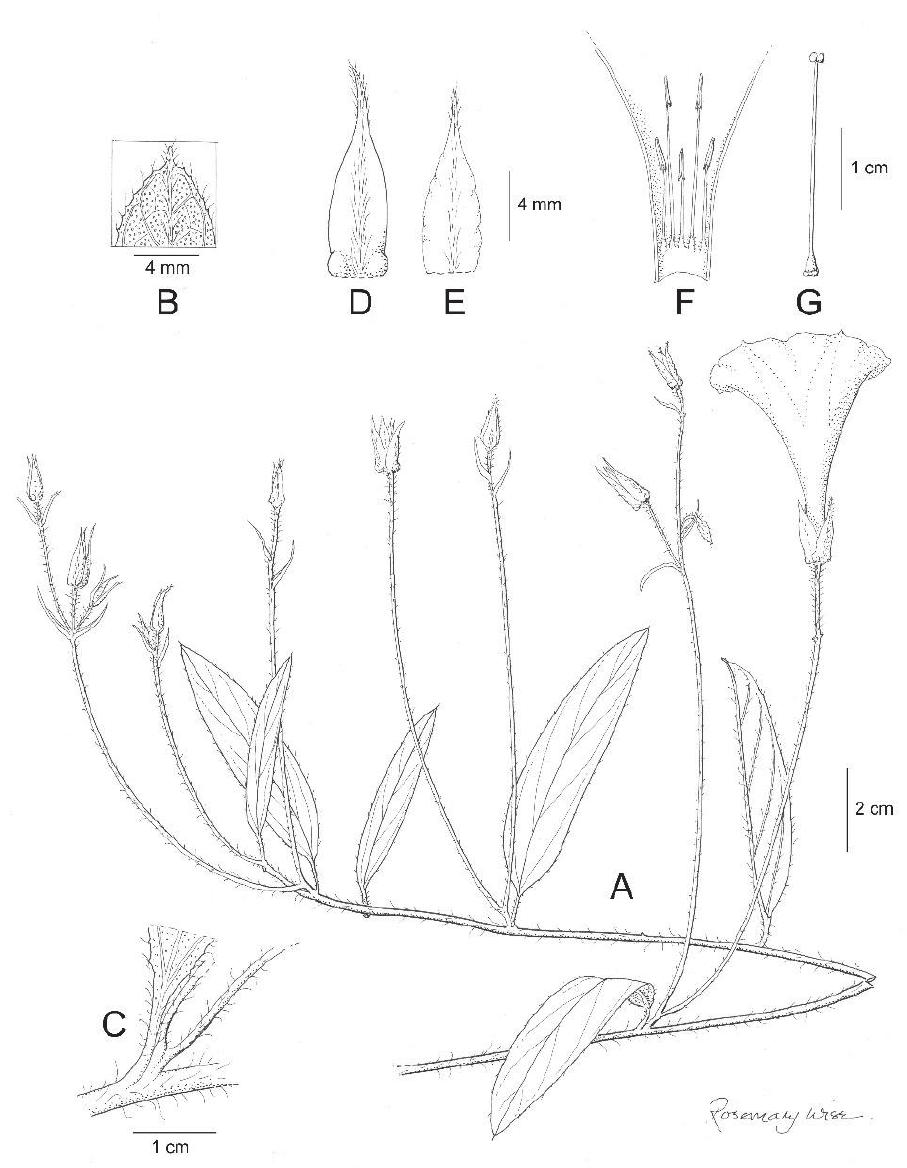
Figure 7. Ipomoea dolichopoda . A habit B leaf apex C leaf base, showing peduncle and inflorescence D Outer sepal e inner sepal F corolla opened out to show stamens G ovary and style. Drawn by Rosemary Wise from I. Basualdo